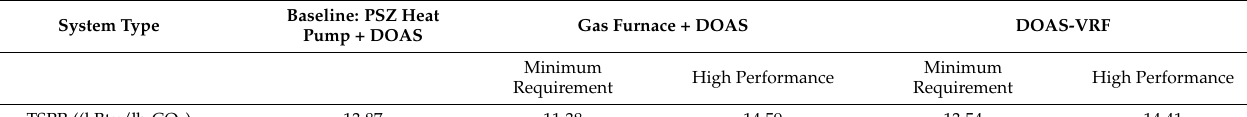
Table 4. System configurations for a retail building analyzed using HVAC System Performance